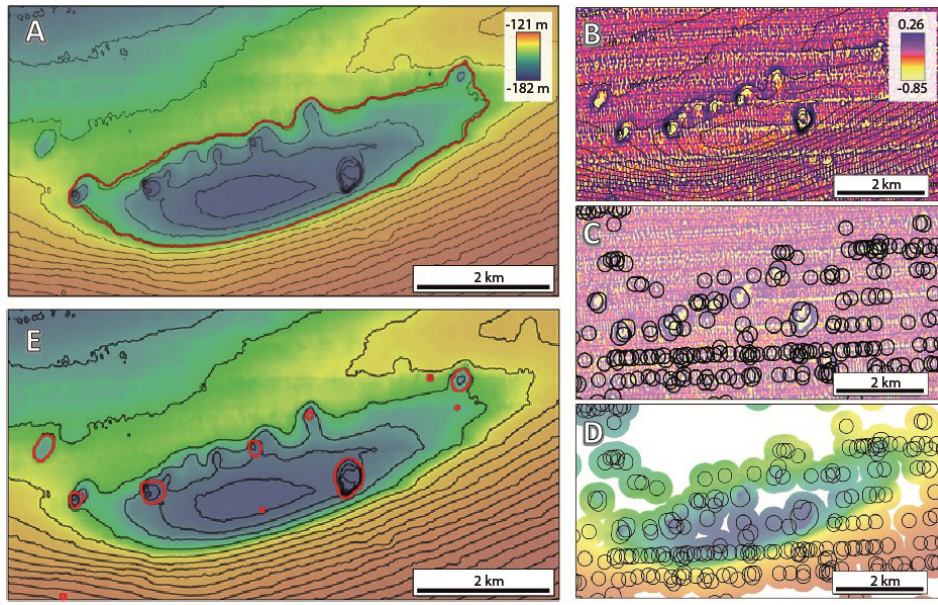
Figure 6. ( A ) Example of a small basin initially mapped by the Delineation Tool as a confined depression (contour lines every 1 m); ( B ) Detail of the raster obtained by applying a High Pass filter followed a Low Pass filter; ( C ) Black polygons delineate areas of negative values within the filtered dataset (in yellow), which can correspond to either pockmarks or artefacts; ( D ) Clipped bathymetric dataset based on the delineated polygons; ( E ) The result of running the Delineation Tool with a clipped